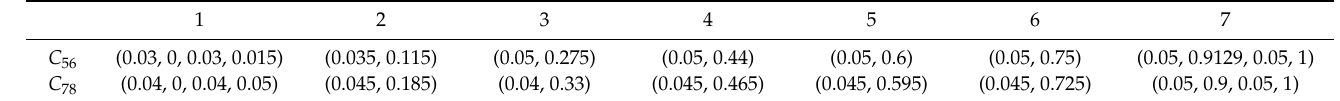
Table 4. Parameters of the membership functions designed for C 56 and C 78 .